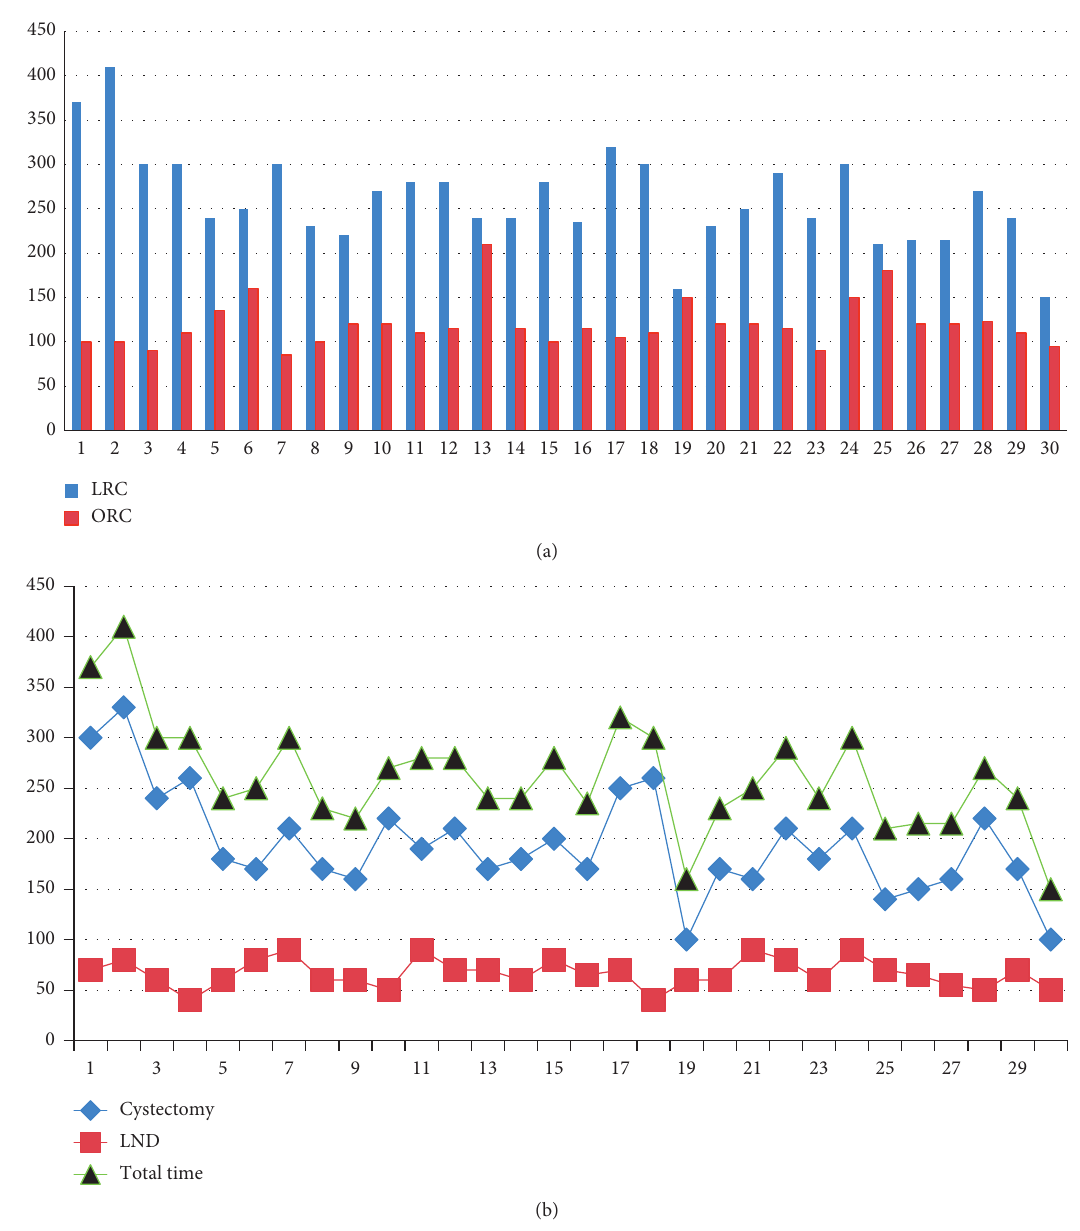
Figure 3: (a) Comparison of operative duration between open and laparoscopic cystectomy. (b) The difference in OR time between the first 15 laparoscopic cases (mean: 280 minutes ± 52) and the last 15 laparoscopic cases (mean: 242 minutes ± 49) ( P � 0 .